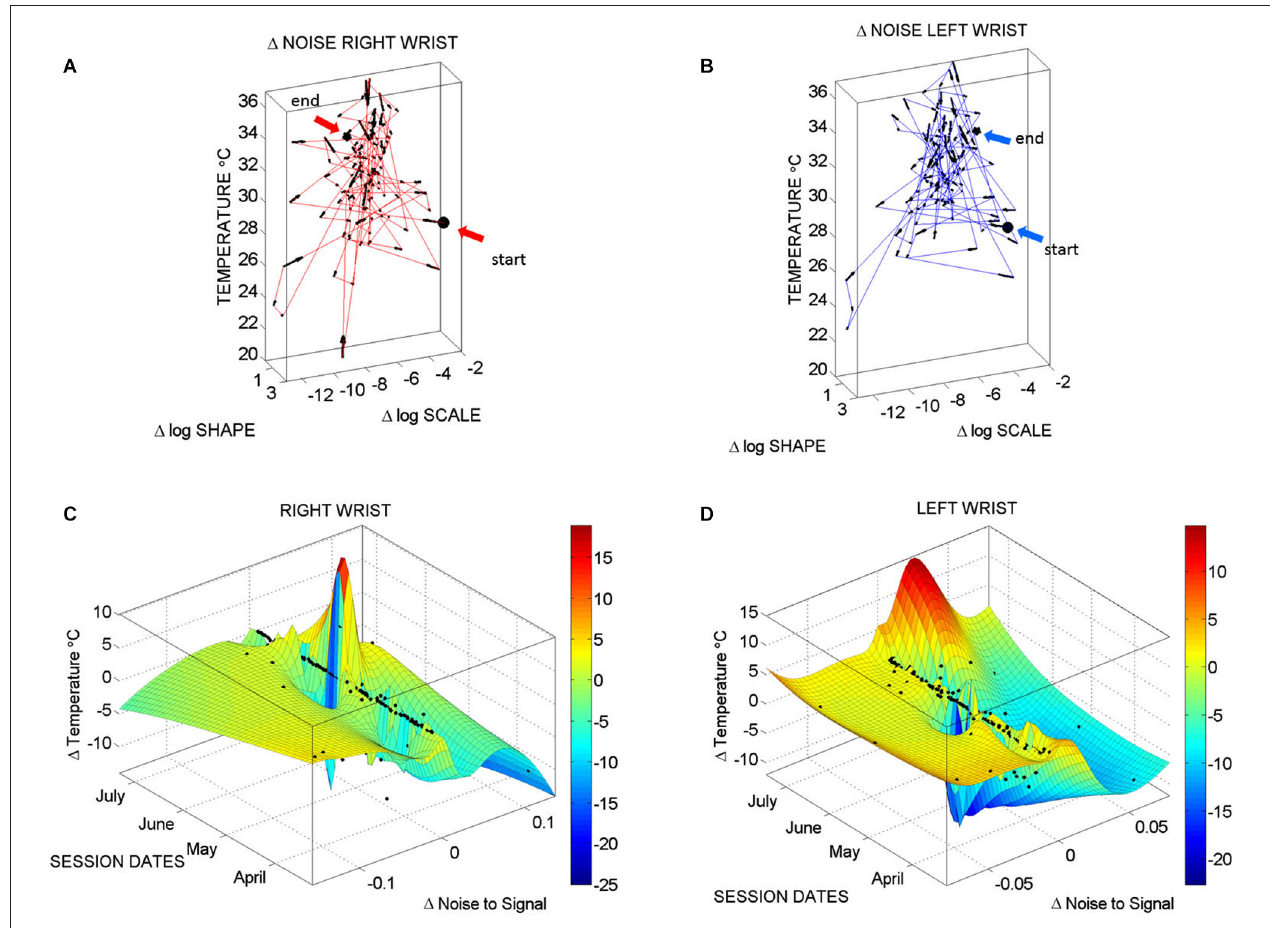
level in the maximal deviations from the mean acceleration. Notice that the area showing the sharpest rate of change in temperature and noise-to-signal levels was registered in May. (D) The surface fitting the 124 longitudinal data points from the left wrist shows decrease in the rate of change of temperature in May, followed by a gradually slow increase of this parameter across the subsequent months of June and July. In both cases there are also points aligned at near zero-change in noise-to-signal ratio for the motion. These are the points where the signatures of variability in the motion patterns registered by the sensors were more stable and had more steady state of temperature levels as